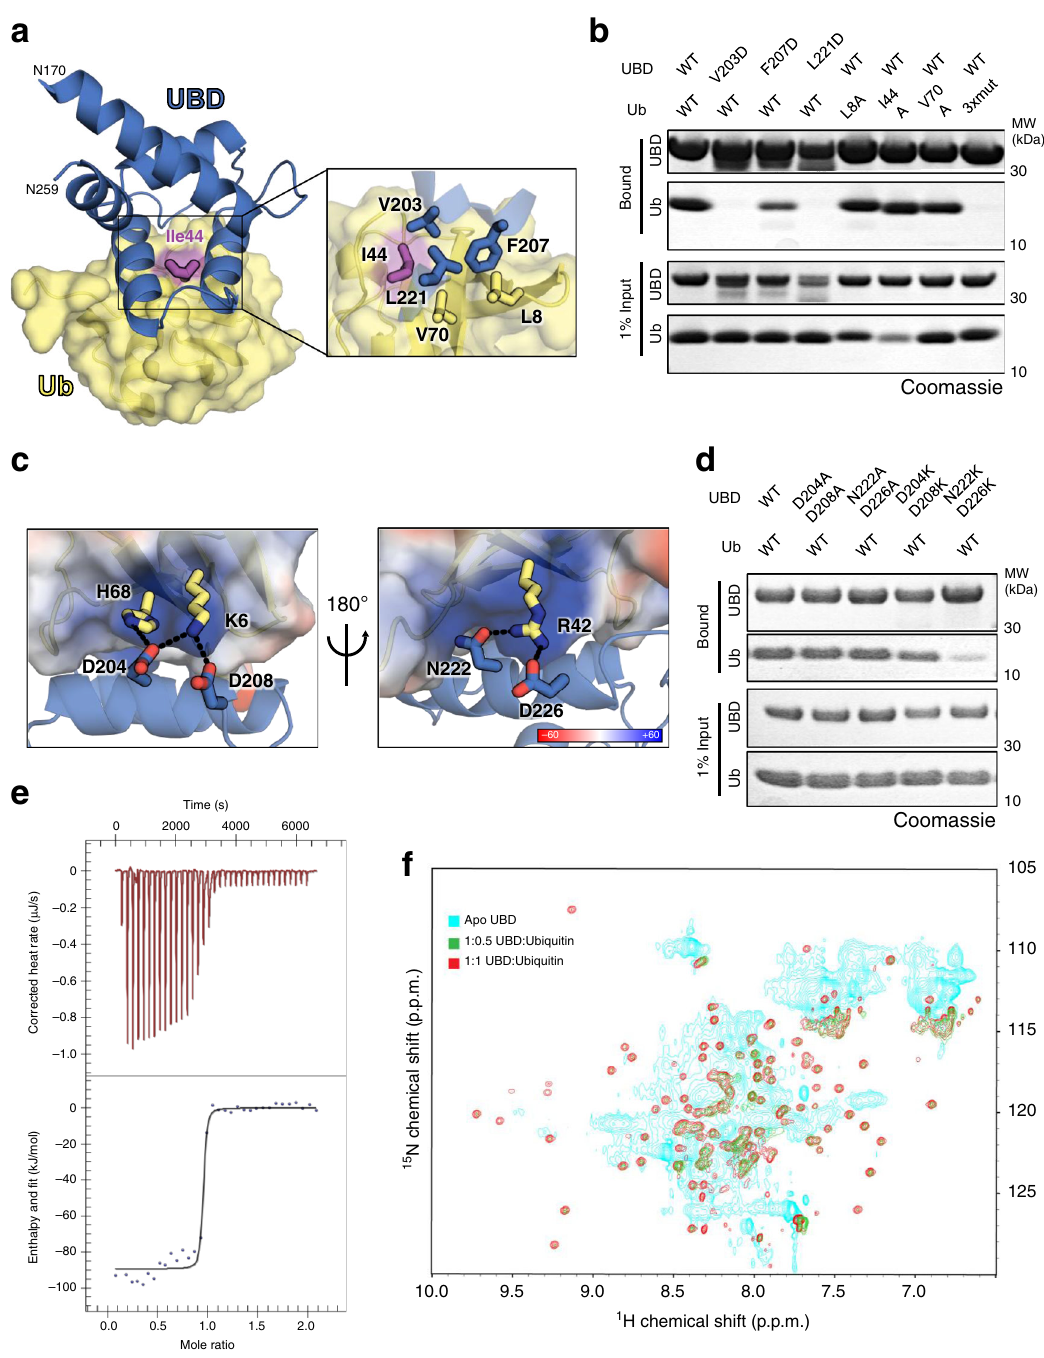
Fig. 5 The OtDUB UBD has unusually high af fi nity for ubiquitin. a Detailed view of hydrophobic interactions between the OtDUB UBD (blue) and ubiquitin (yellow). b Glutathione S -transferase-pulldown experiments between GST-UBD 170 – 259 (25 μ M) and 6His-ubiquitin (75 µ M) or mutants thereof. Protein mixtures were combined and incubated with glutathione-charged resin, washed extensively, and bound complexes were eluted and resolved by SDS-PAGE ( n = 2). Source data are provided as a Source Data fi le. c Detailed views of electrostatic interactions between the OtDUB UBD (blue cartoon and sticks) and ubiquitin (shown in transparent electrostatic potential surface). Positive and negative charges are in blue and red, respectively. d As in b , but with dual charge-neutralizing or charge-reversed mutants of the ubiquitin-binding interface of the UBD ( n = 2). Source data are provided as a Source Data fi le. e Representative ITC titration of UBD with ubiquitin. Upper panel shows raw injection data over time, and the lower panel shows integrated heats over the course of the reaction ( n = 3 ). Performed with 140 µ M mono-ubiquitin being titrated into 20 µ M of the OtUBD 170 – 264 . f 1 H - 1 5N HSQC spectral overlay for the OtUBD 170 – 264 domain of OtDUB: apo (pink), in 1:0.5 (turquoise), and 1:1 (dark blue) complexes with unlabeled ubiquitin. Data were obtained at 293 K, pH = 7.5, at 600 MHz. Concentrations of OtUBD 170 – 264 in the samples are 1.55 mM (apo), 1.41 mM (1:0.5 complex), and 1.29 mM (1:1